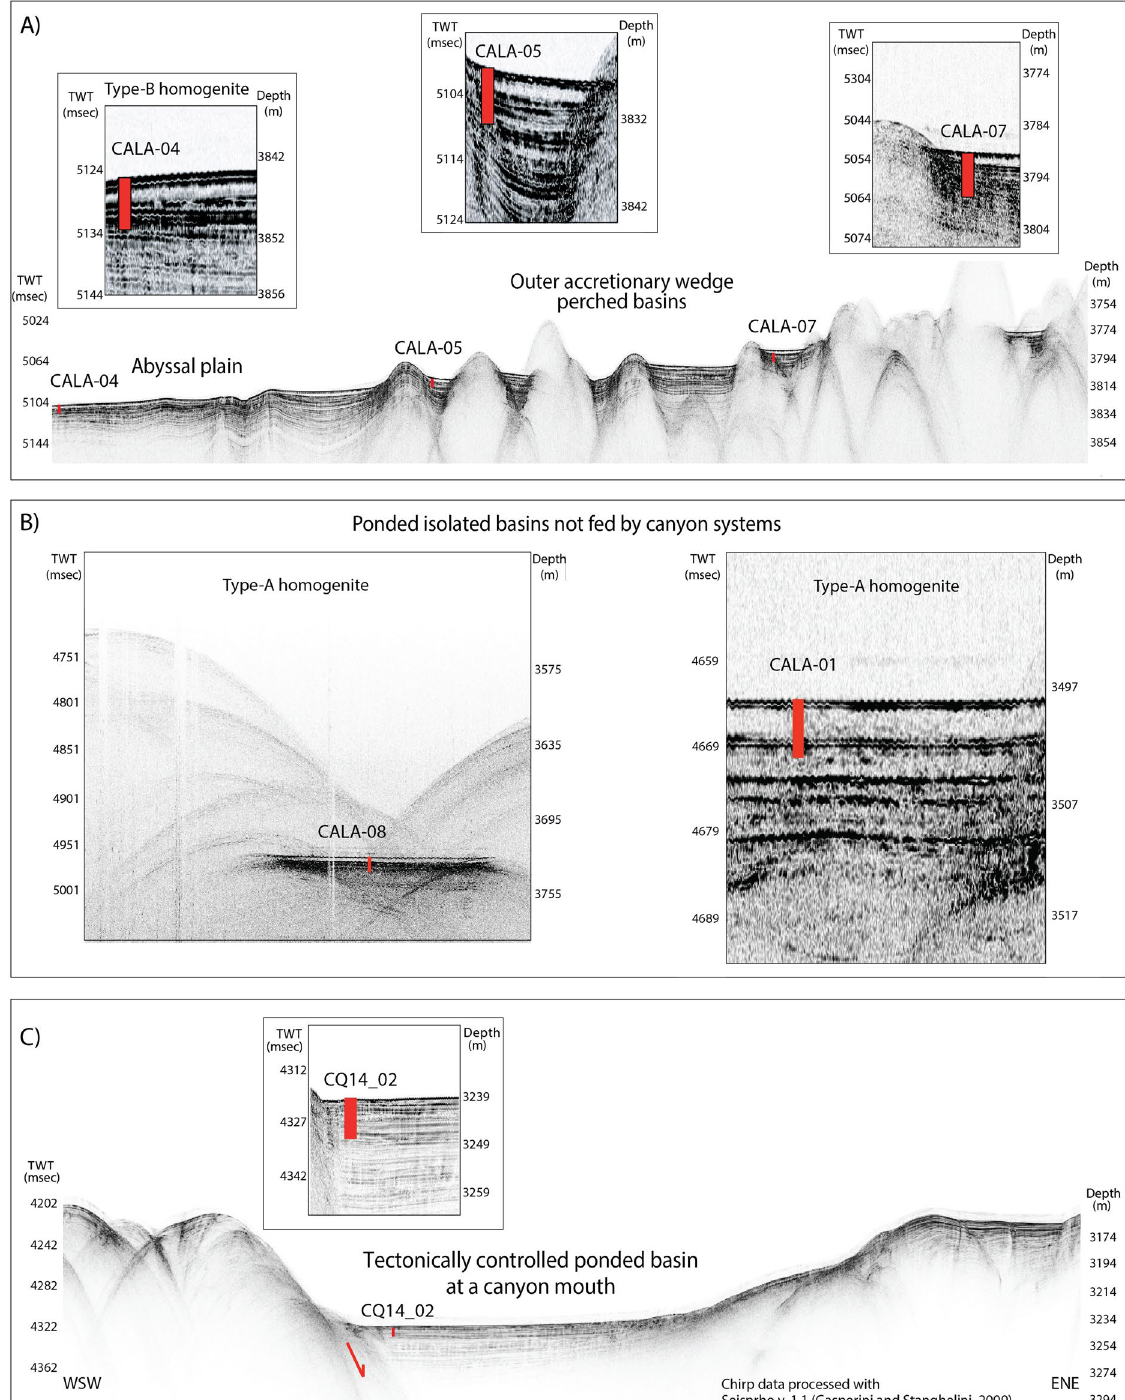
Figure 2. Sub-bottom CHIRP profiles across the coring sites investigated in this study (see Fig. 1 for location of Chirp profiles and gravity cores). ( A ) The Chirp profile across the core transect is collected at the transition between the undeformed abyssal plain and the accretionary wedge. Core CALA-04 represents the type-B homogenite 18 . ( B ) Chirp profile across the coring sites of CALA-01 and -08 in ponded isolated basins not fed by canyon systems (type-A homogenite 18 ). ( C ) Chirp profile collected across the coring site CQ14_02 in the tectonically controlled slope basin directly fed by the canyon system from the Messina Straits region. Gravity cores are represented by red rectangles on the CHIRP profiles. Seismic data have been processed and geo- referenced using the open-source software Seisprho 72